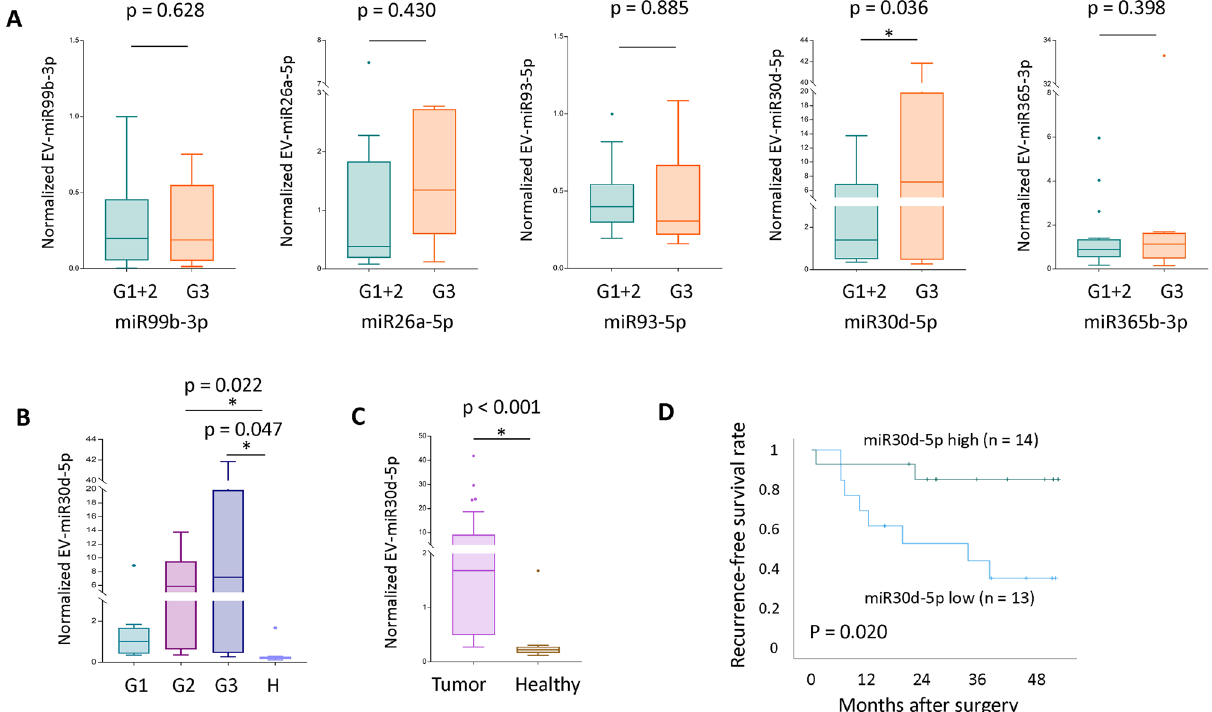
Figure 4. ( A ) Quantification of five miRNAs obtained from the serum extracellular vesicles of 44 patients for a validation study. G1 + 2 (LVI +) cohort has significantly lower miR-30d-5p levels ( p = 0.036) than the G3 (LVI–) cohort. ( B ) miR-30d-5p levels in the healthy control group were significantly lower than those in the G2 ( p = 0.022) and G3 ( p = 0.047) cohorts. ( C ) miR-30d-5p levels in the healthy control group were significantly lower than those in the patients with lung adenocarcinoma ( p < 0.001). ( D ) Recurrence-free survival curves of 27 patients with stage I lung adenocarcinoma according to their miR-30d-5p levels. EV extracellular